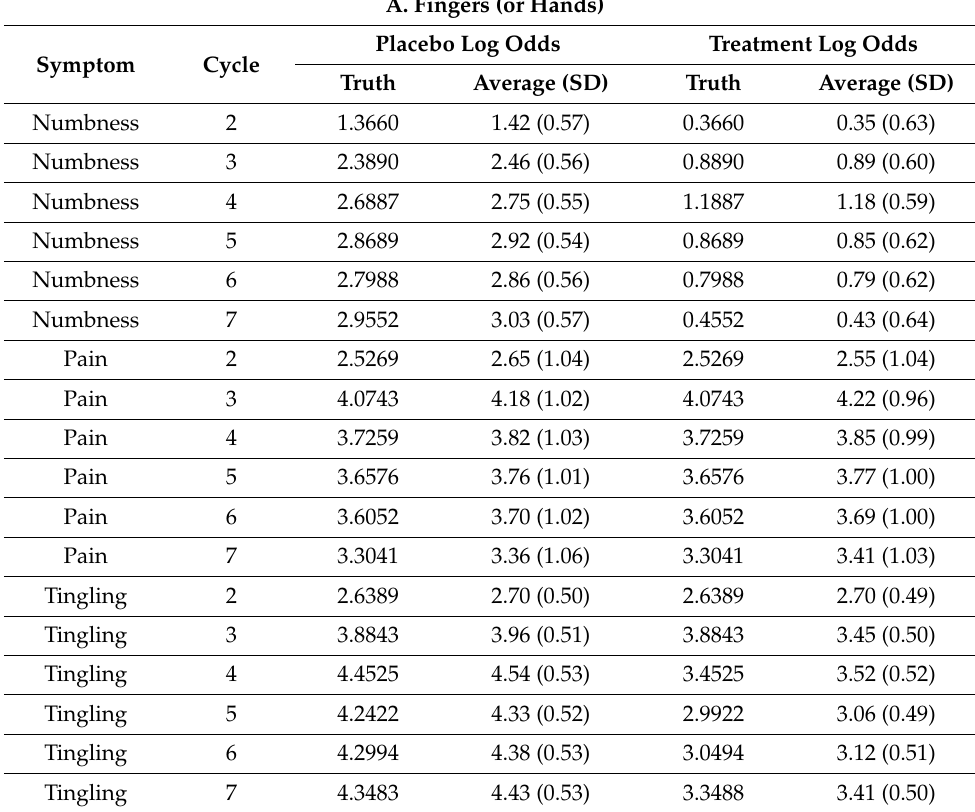
Table 3. Design application. Scenario 2: For each log odds (compared with cycle 1, baseline), we report the average estimate over the 1000 datasets generated as a measure of the true estimate and the corresponding standard deviation (SD) or empirical standard error. The “true” estimates of the log odds compared with cycle 1 (baseline) for the placebo arm were based on the analysis of the pooled placebo arms from two recently completed OIPN prevention trials (NCCTG N08CB; MC11C4). The “true” estimates of the log odds compared with cycle 1 (baseline) assumed for the treatment arm were hypothesized consistent with an arm-by-time interaction such that a large effect for numbness, a moderate effect for tingling and no effect for pain was assumed. Note that cycle 1 served as a baseline (prior to oxaliplatin exposure), while patient-reported responses measured at each two-week cycle (2–6), as well as at 2 weeks post-cycle 6 (day 1 of cycle 7, prior to oxaliplatin treatment), served as the post-baseline